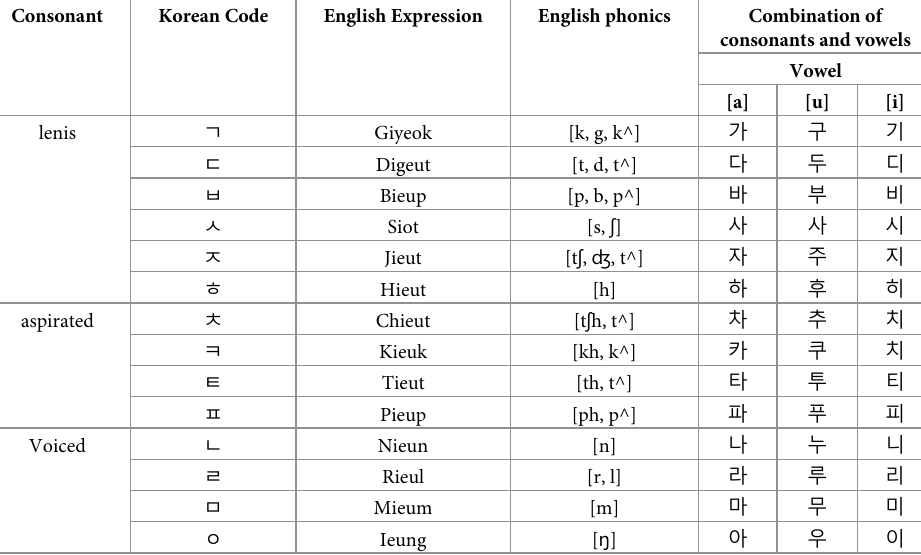
Table 1. Manners of consonant of English and Korean